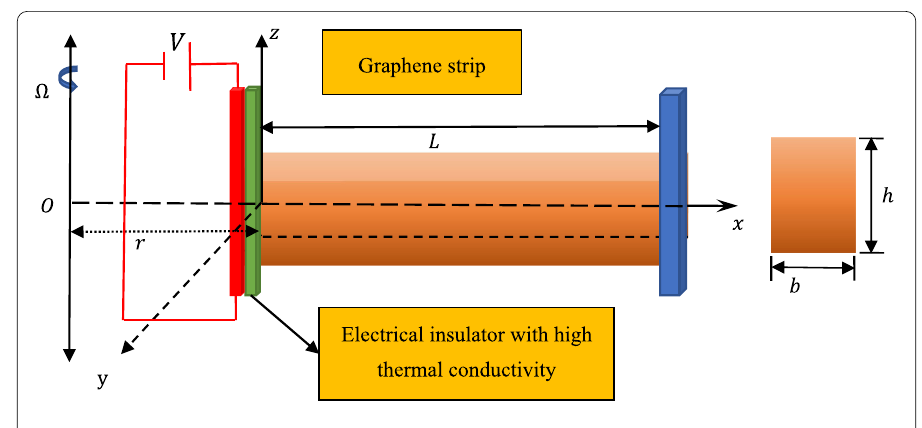
Figure 1 A schematic representation of the revolving thermoelastic